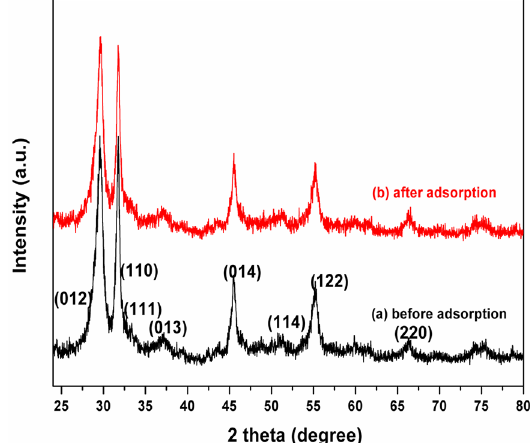
Figure 1. XRD patterns of the BiOI hierarchical structure before and after RhB adsorption